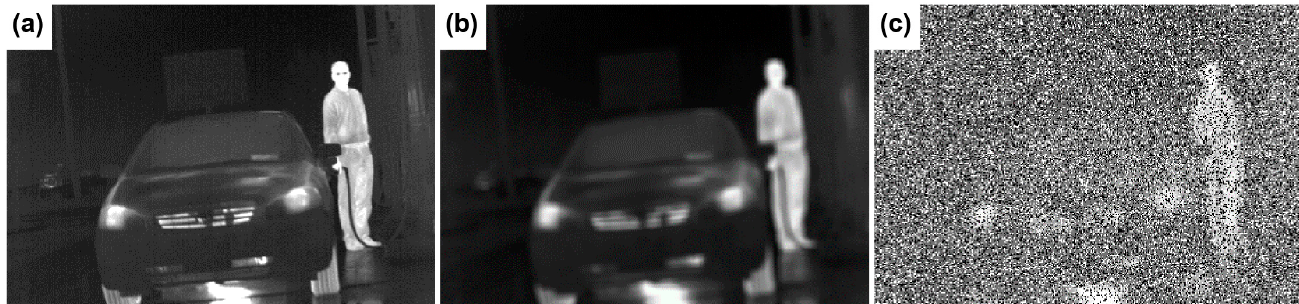
Figure 4. The station image with different degrees of degradation. ( a ) The original image, ( b ) the 7 × 7 box blur, and ( c ) the 7 × 7 box blur + 40% salt-and-pepper noise.